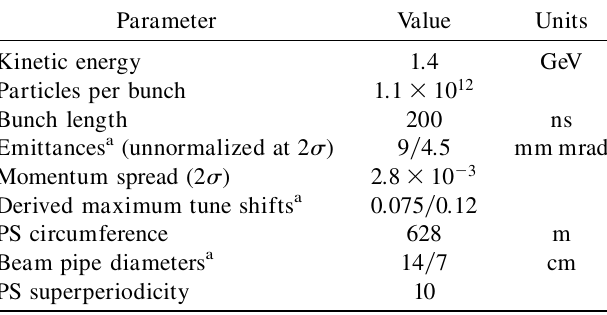
FIG. 1. (Color) Experimental results on final rms emittance (of Gaussian fit) and beam current relative to